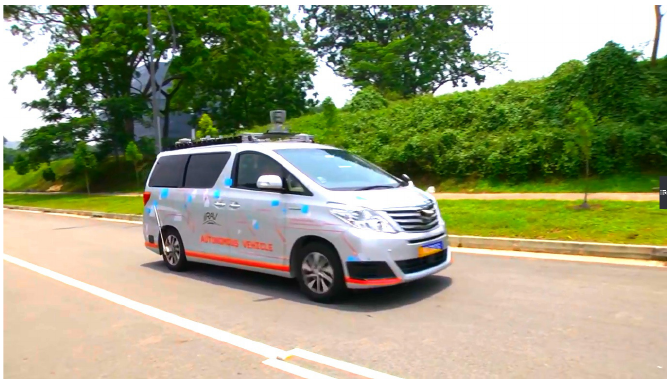
Figure 11. Autonomous vehicle equipped with